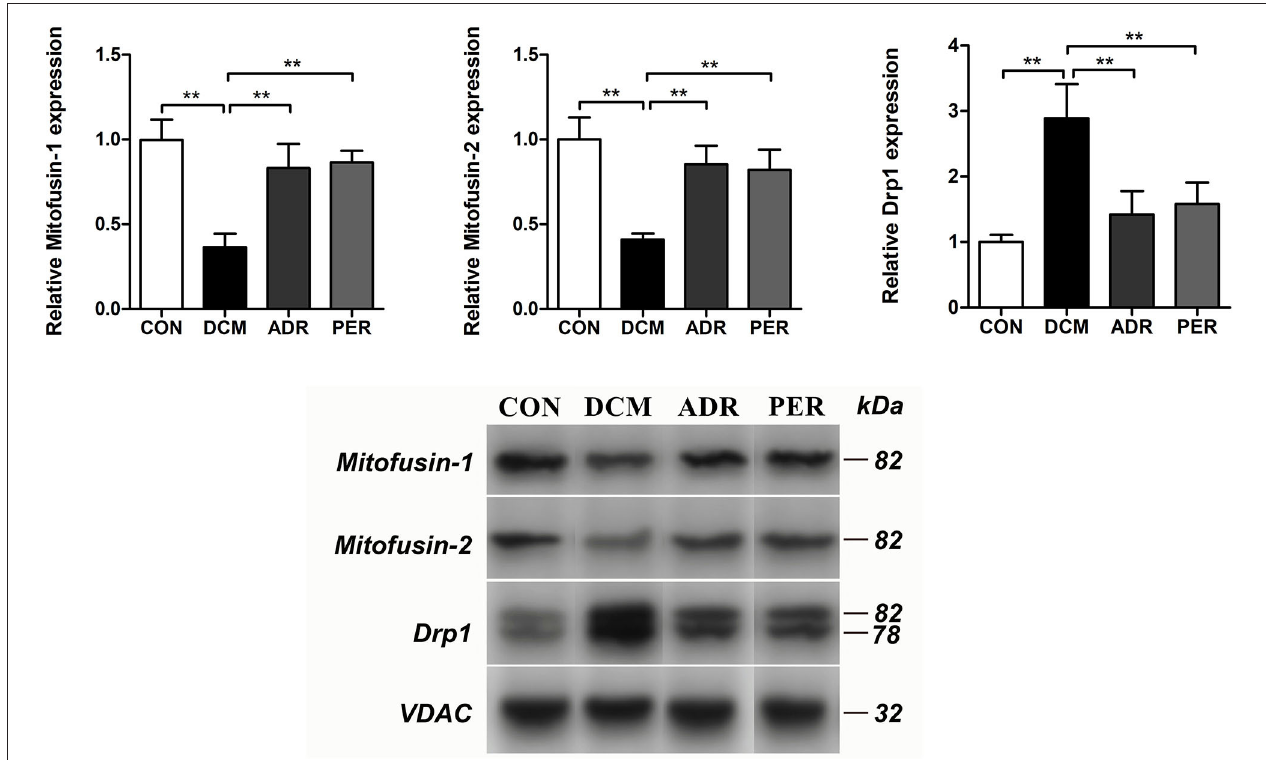
FIGURE 6 | Effects of ADR on the relative proteins of mitochondrial dynamics in DCM rats. Compared to DCM group, the relative expression of Mitofusin-1 and Mitofusin-2 proteins increased in ADR and PER group. The relative expression of Drp1 protein decreased in ADR and PER group in comparison with DCM group. CON, control; DCM, diabetic cardiomyopathy; ADR, adropin; PER, perindopril. Values are expressed as mean ± standard deviation. * P < 0.05, ** P <